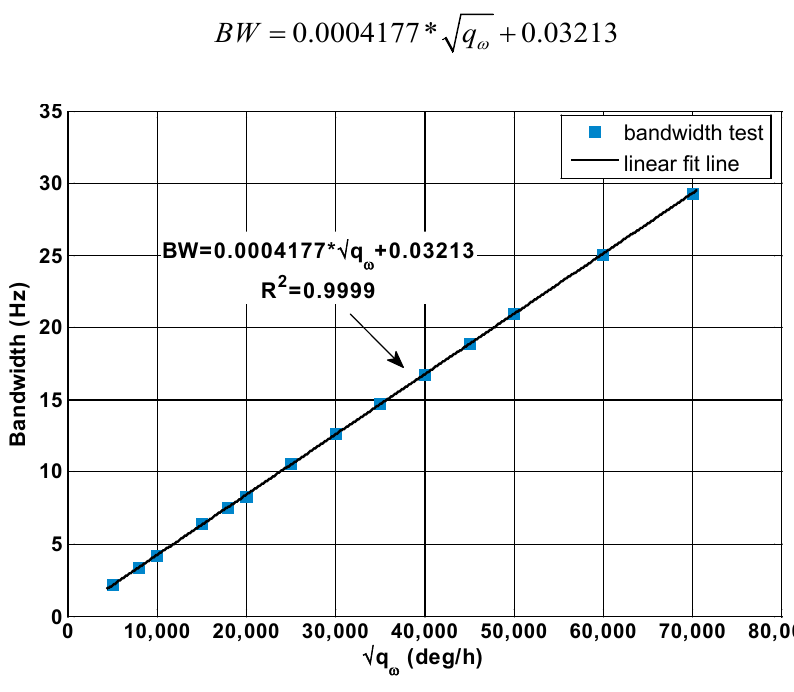
Figure 3. Linear fit results of the KF − 3 dB bandwidth with q